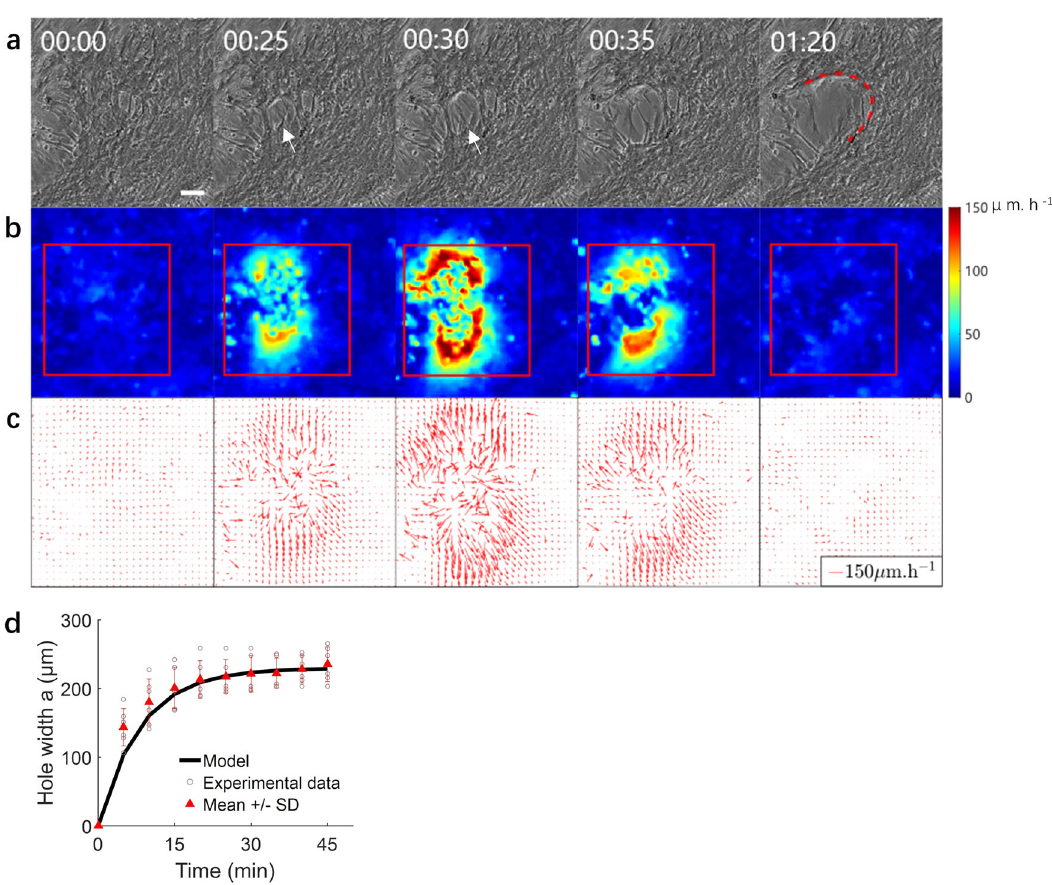
Fig. 2 Dynamics of hole development. a Phase contrast images of SMCs at different times pre and post-hole development. White arrows denote the position of hole initiation. Fit of the experimental shape of the hole edge by a parabola (red curve) whose equation is indicated in the text. Times are in hours and minutes. Scale bar: 100 μ m. b Heat map of SMC tissue speed corresponding to the velocity fi eld shown in ( c ). c Velocity vector fi eld in the SMC tissue showing the larger velocities in the hole vicinity. d Time evolution of hole width. Comparison between the mathematical model of hole width evolution (solid black curve) to experimental data (brown circles), mean ± SD in red, N = 6). The stretching time (1/ C ) of hole opening can be observed at the beginning of opening. Interpretation of the constant C is indicated in the